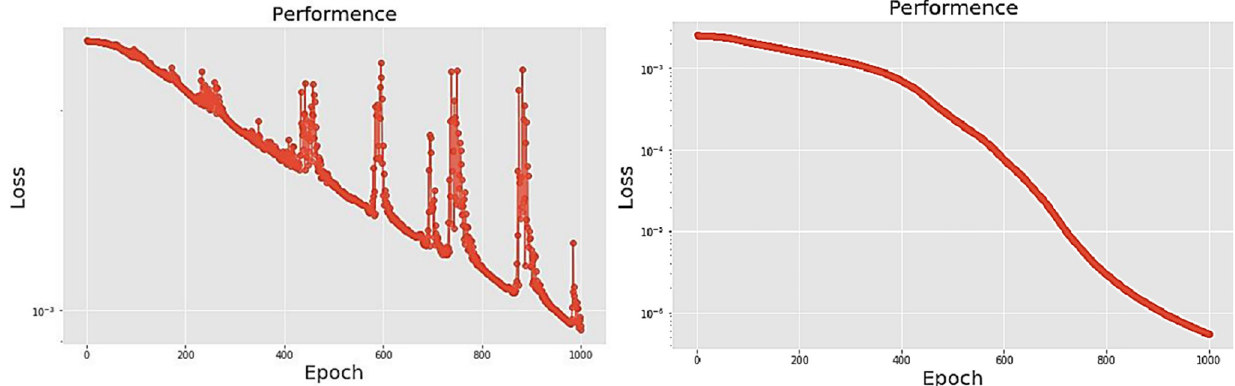
Fig 15. (a) The graph shows the performance of LPC-DNN-20-layer model; (b) The graph shows the performance of LPC-PCA-DNN-20-layer model.